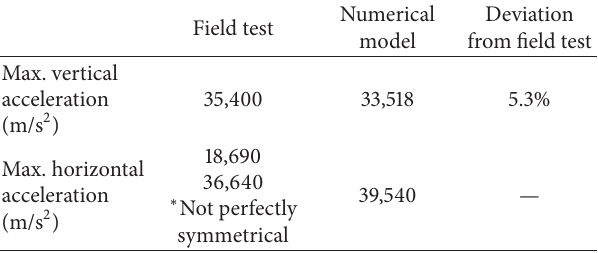
Table 10: Acceleration from field test and numerical model for the multilayer concrete